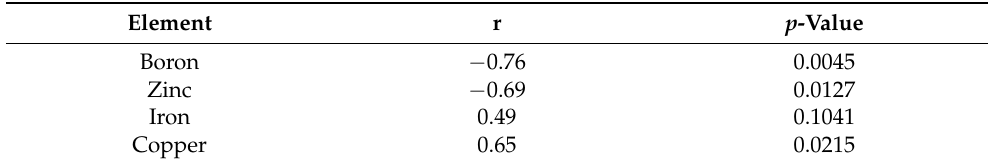
Table 5. Pearson’s correlation coefficient (r) comparing soil Mn with B, Zn, Fe, and Cu as a function of soil Mn application for HLB-affected 2-year-old ‘Valencia’ ( Citrus sinensis (L.) Osbeck) trees. Total sample (N = 12) for each